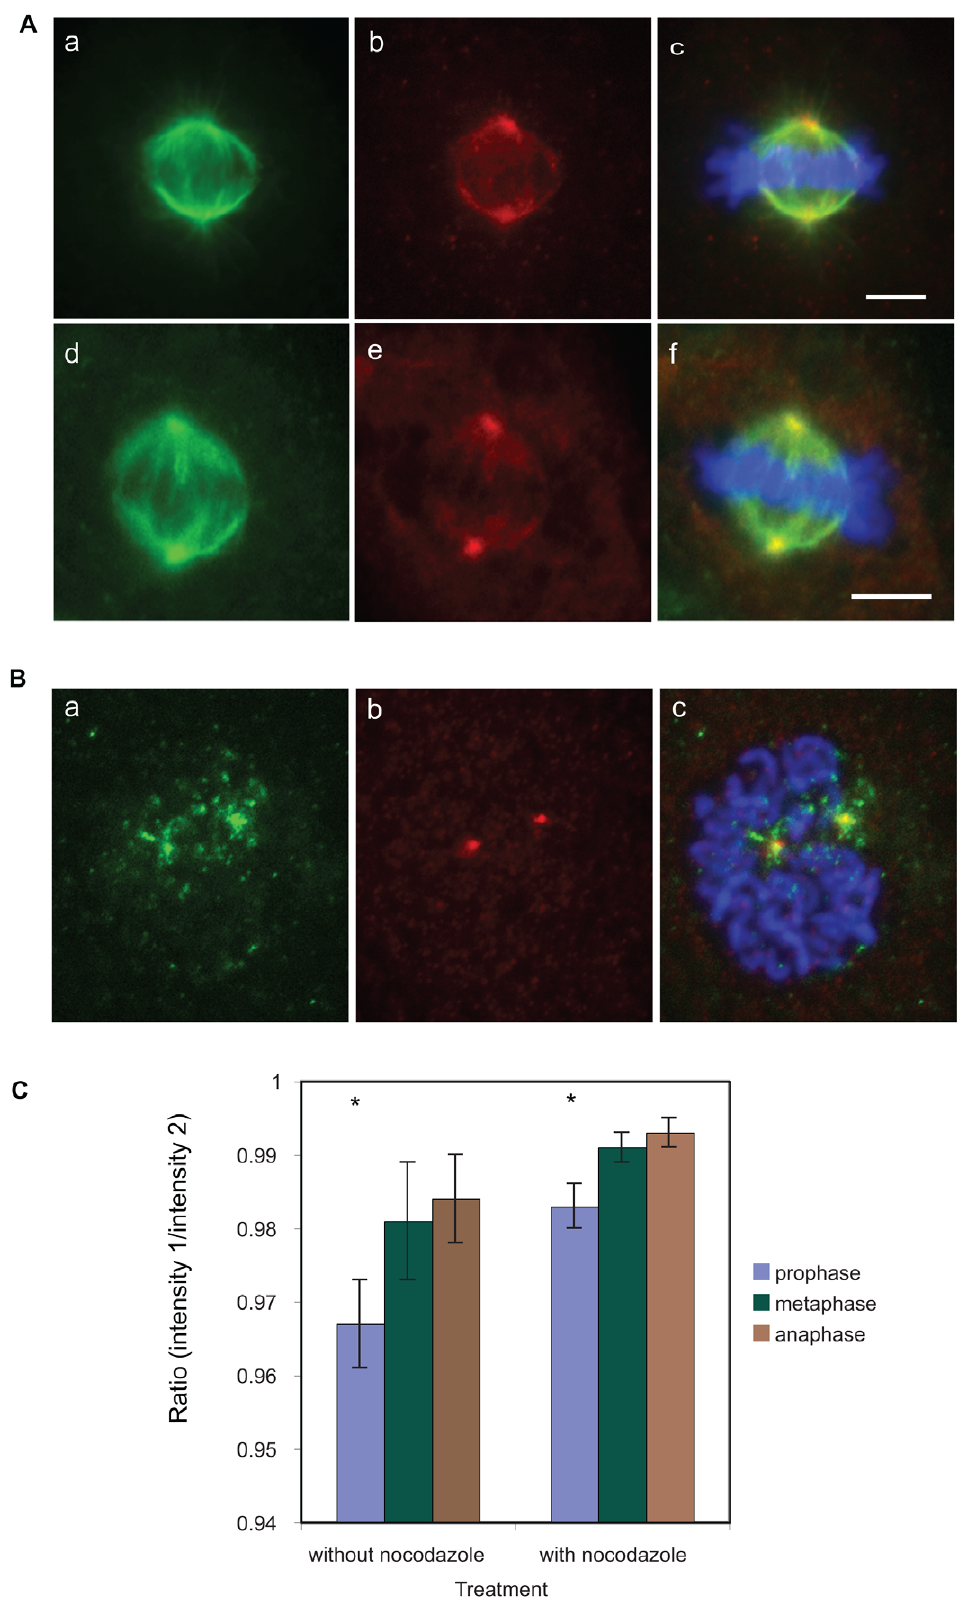
Figure 10. Characterisation of antibody 1A11 binding to EB1 in mitotic NRK-52E cells. A. Binding pattern of the EB1 specific antibody 1A11 in mitotic NRK-52E cells. The antibody binds to the spindle poles in fixed and immunostained cells (a–c) and microinjected, fixed and stained cells (d–f). Tubulin green, EB1 red, DAPI blue. Scale bar=5 m M. B. EB1 staining patterns of spindle poles at prophase appear to be uneven as indicated by immunofluorescence of fixed and stained NRK-52E cells. EB1 green (panel a), centrin red (panel b), DAPI blue. Scale bar=5 m M. C. EB1 is more PLoS ONE |